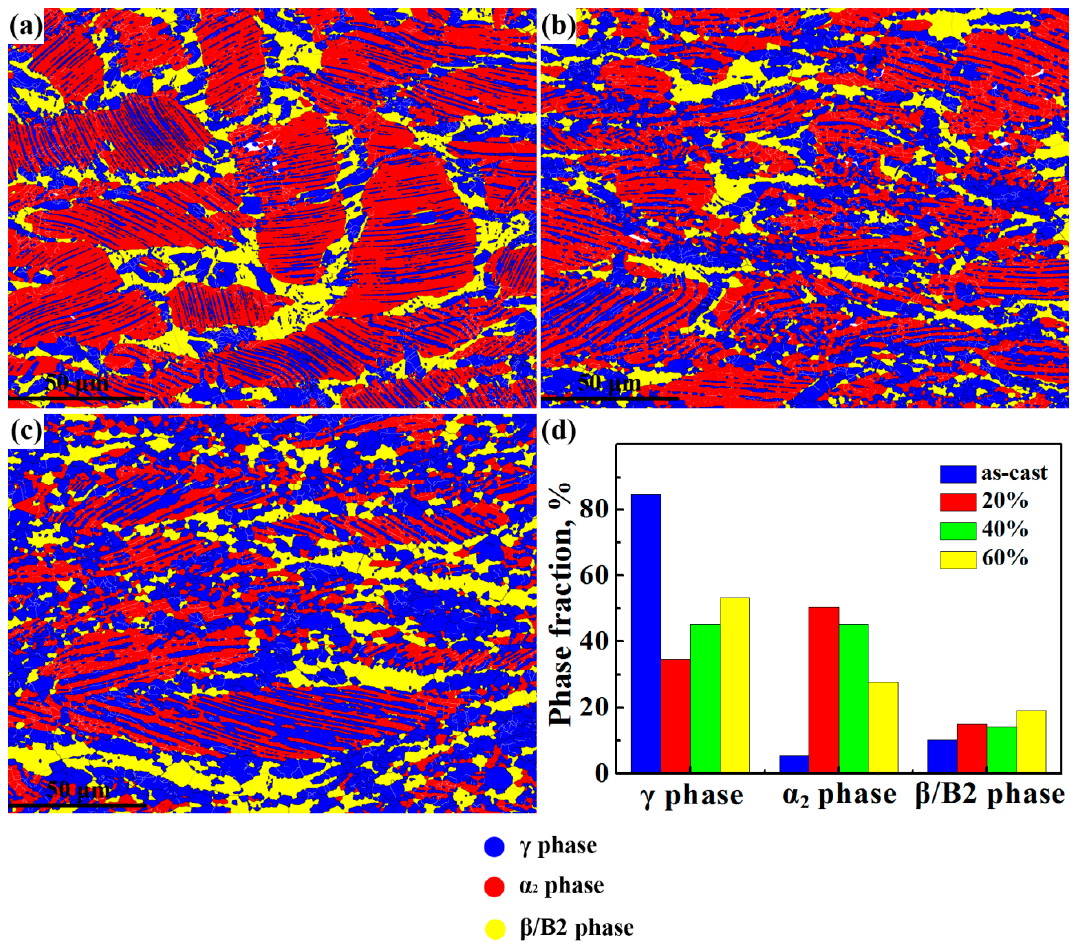
Figure 7. Phase maps of Ti-44Al-4Nb-1.5Cr-0.5Mo-0.2B alloy compressed at 1473 K with a strain rate of 0.01 s − 1 : ( a ) 20% reduction; ( b ) 40% reduction; ( c ) 60% reduction; and ( d ) phase fraction graph.